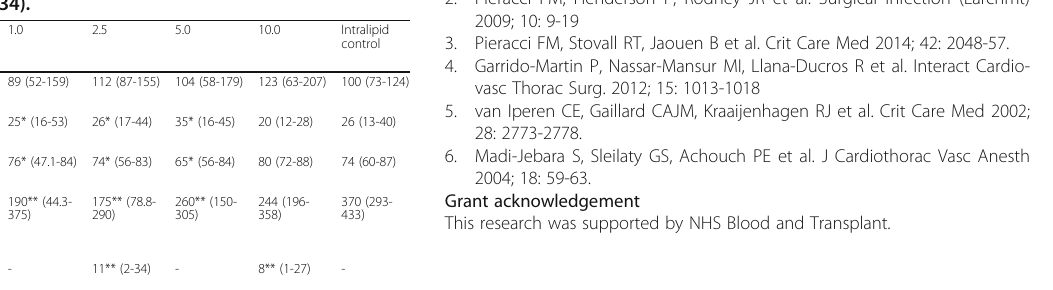
Table 21 (abstract A35). Outcomes suitable for